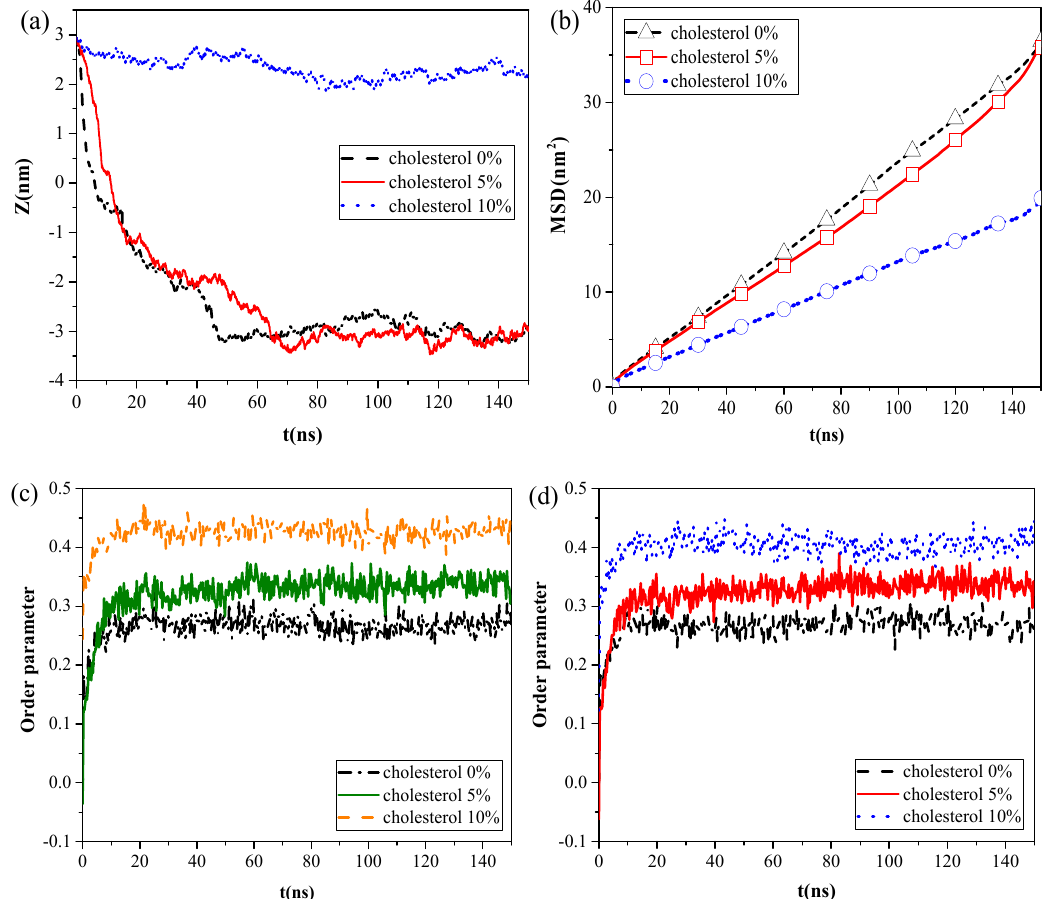
Figure 4. E ff ect of cholesterol content of the monolayer: ( a ) centroid–centroid distance between the CaSO 4 NP and the monolayer, ( b ) MSDs of lipid molecules in the CaSO 4 NP monolayer system, and ( c , d ) order parameters for the systems without NPs and with the CaSO 4 NP.